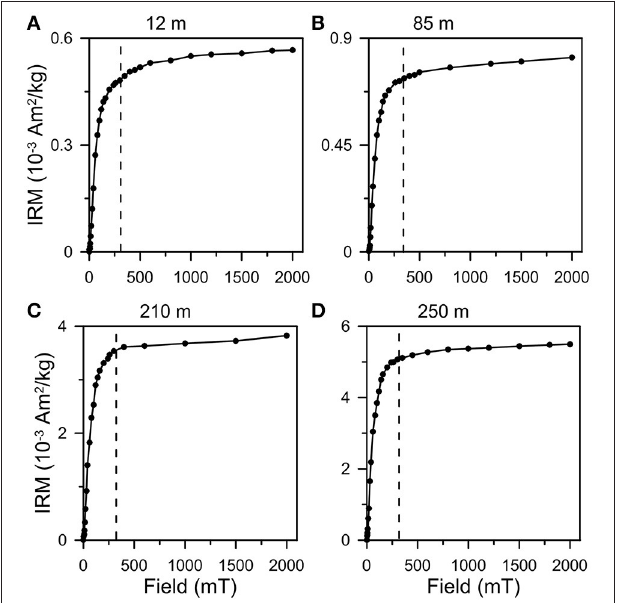
FIGURE 5 | Isothermal remanent magnetization (IRM) acquisition curves. (A) 12m, (B) 85m, (C) 210m, and (D) 250m. The dashed vertical lines at 300 mT are shown to aid distinction between low- and high-coercivity portions of the IRM acquisition curves.